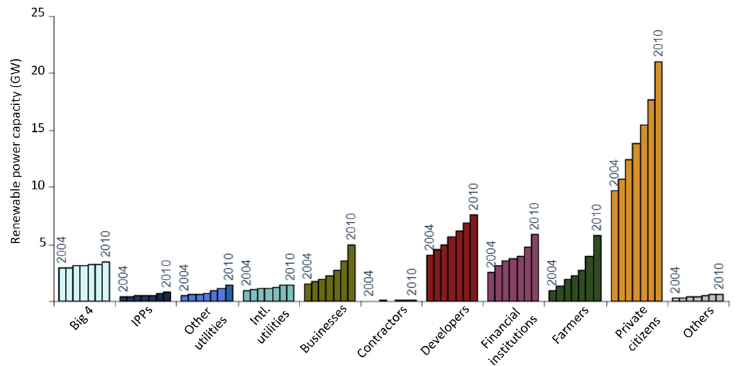
Figure 3. Evolution of the ownership structure of renewable power capacity in Germany between 2004–2010. Source: Adapted with permission from Ref. [121]. 2011, trend: research Between 2000–2010, wind power quadrupled its production, biomass electricity gen- eration increased by a factor of 13, biogas by a factor of 35, and solar PV by a breath-taking factor of 195 [97]. The 2010 target of 12.5% market share was amply surpassed by 2007, reaching a 17% share by decade’s end [97]. The prolonged use of FiTs throughout the 2000s therefore drove the emergence of an actor-diverse RES-E market configuration, it- self spearheaded by a drastic increase in citizen-led developments via cooperative associ- ations (Figure 4) (RES Association 2, C-Association 2) [123]. Germany’s RES-E market be- came characterised by diversity in the generation base—both in terms of power capacity and actor configuration—and by concentration in its supply and distribution segments (RES Association 2). Figure 4. Evolution of the number of energy cooperatives in Germany between 2000–2017. Source: Adapted from [124]. Yet the emergence of a policy-dependent RES-E market did not occur without its challenges. By decade’s end, climate action progressively ceased to play a dominant role in framing RES promotion while rising support costs became an increasingly salient con- cern dominating public and political debates over Germany’s FiT-based support frame- work (Government 4) [125,126]. In effect, the expansion of renewables throughout the